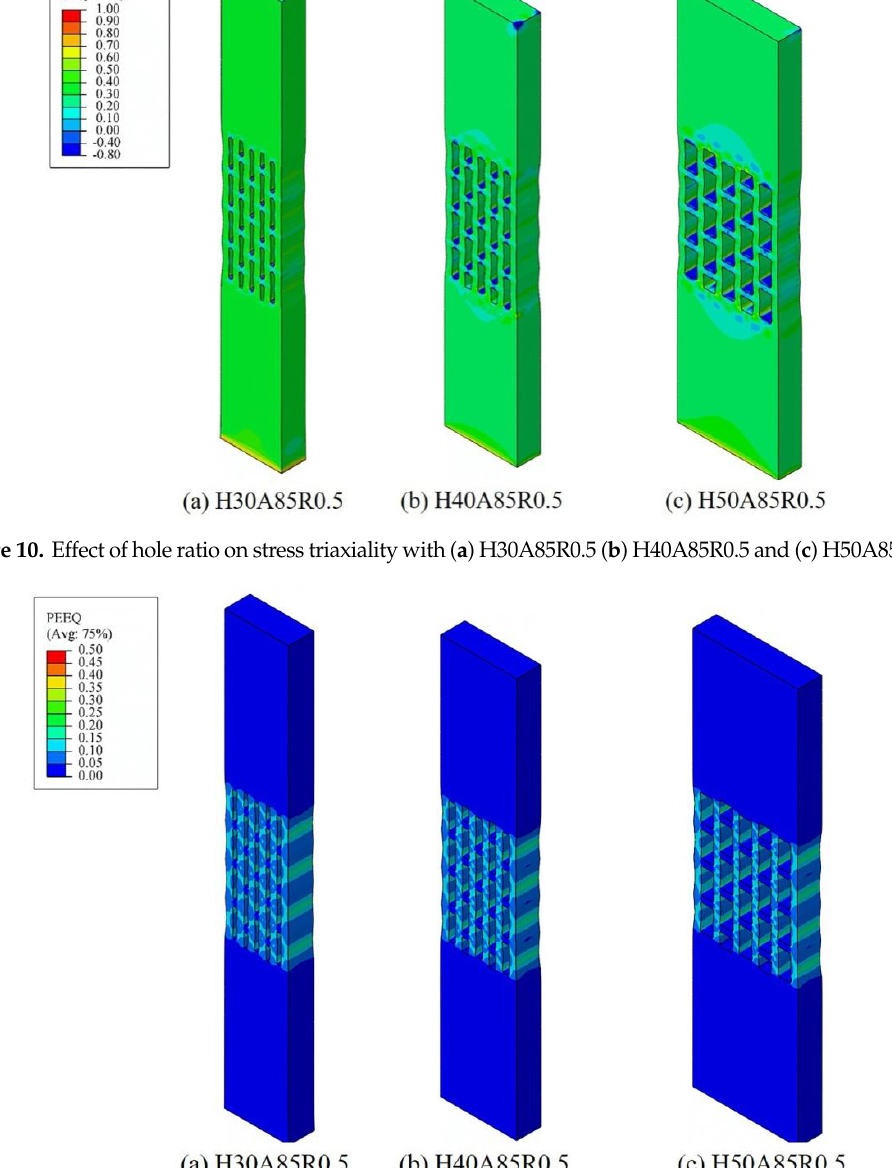
Figure 11. E ff ect of hole ratio on equivalent plastic strain with ( a ) H30A85R0.5 ( b ) H40A85R0.5 and Figure 11. Effect of hole ratio on equivalent plastic strain with (a)H30A85R0.5 (b)H40A85R0.5 and ( c )